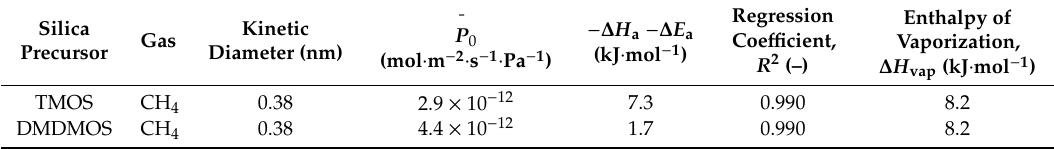
Table 7. Model factors calculated by fitting the permeances through the TMOS-, MTMOS-, and DMDMOS-derived membranes to the surface di ff usion model Equation